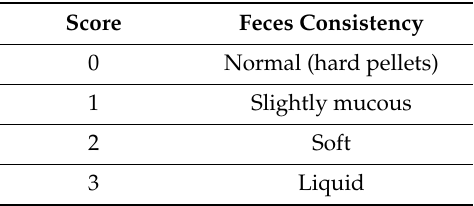
Table 1. Score of diarrhea